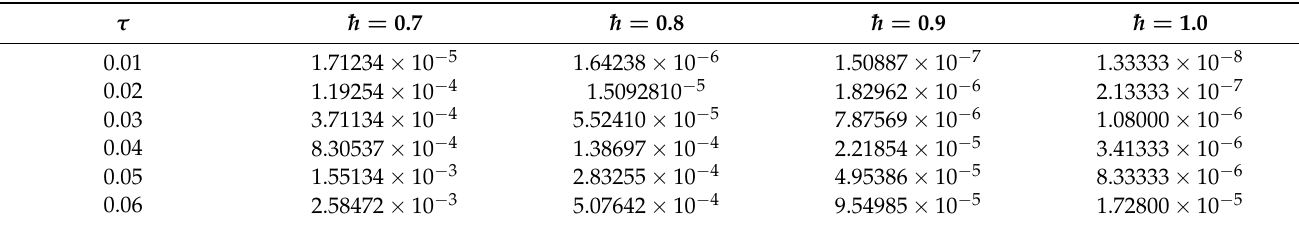
Table 7. The | Ω 4 ( α , τ ) − Ω 3 ( α , τ ) | of Problem 4.3 at varying values of ¯ h at α = 0.002 when ξ = 2.0 determined by the ARPSM at plausible locations in the range τ ∈ [ 0, 0.10 ]